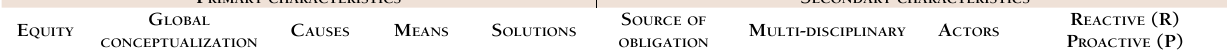
Table 1 Inductive analysis of global health definitions Brown: “Global health” in general, implies consideration of the health needs of the people of the whole planet above the concerns of particular nations. The term “global” is also associated with the growing importance of actors beyond governmental or intergovernmen- tal organizations and agencies.[10] P rimary